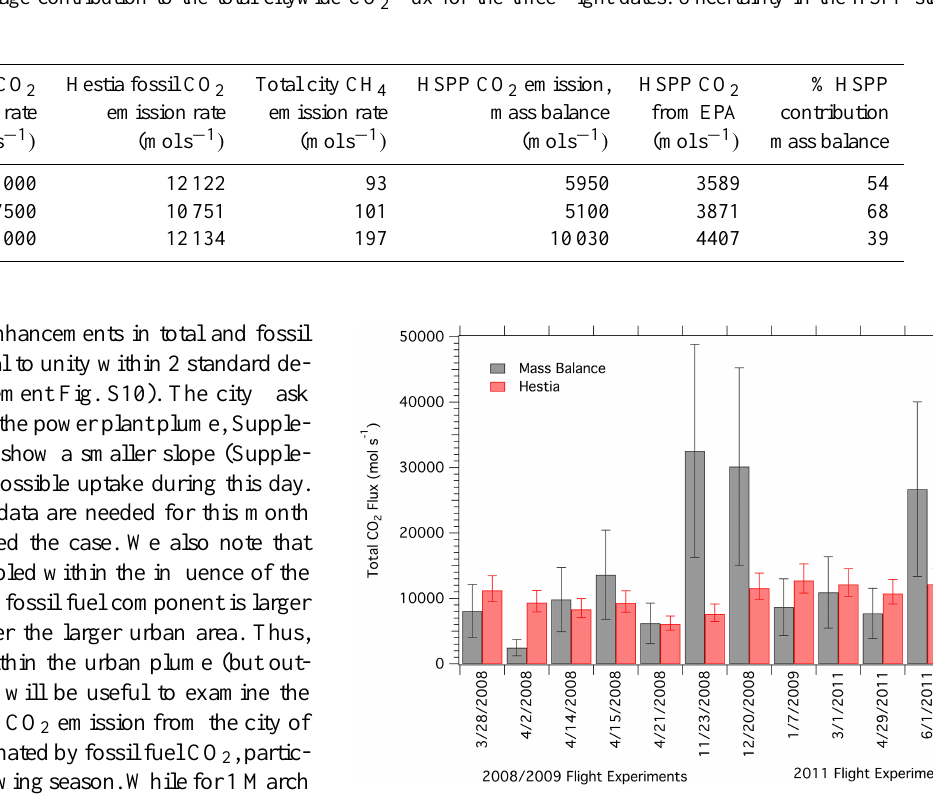
Figure 5. Indianapolis CO 2 emissions for several flight experiments in 2008 and 2011 estimated from the aircraft-based mass balance and Hestia bottom-up approaches. Error bars in the mass balance approach represent our uncertainty estimate of ± 50%, while the Hestia uncertainty is ( − 15, + 20%) at 95% confidence interval for Marion